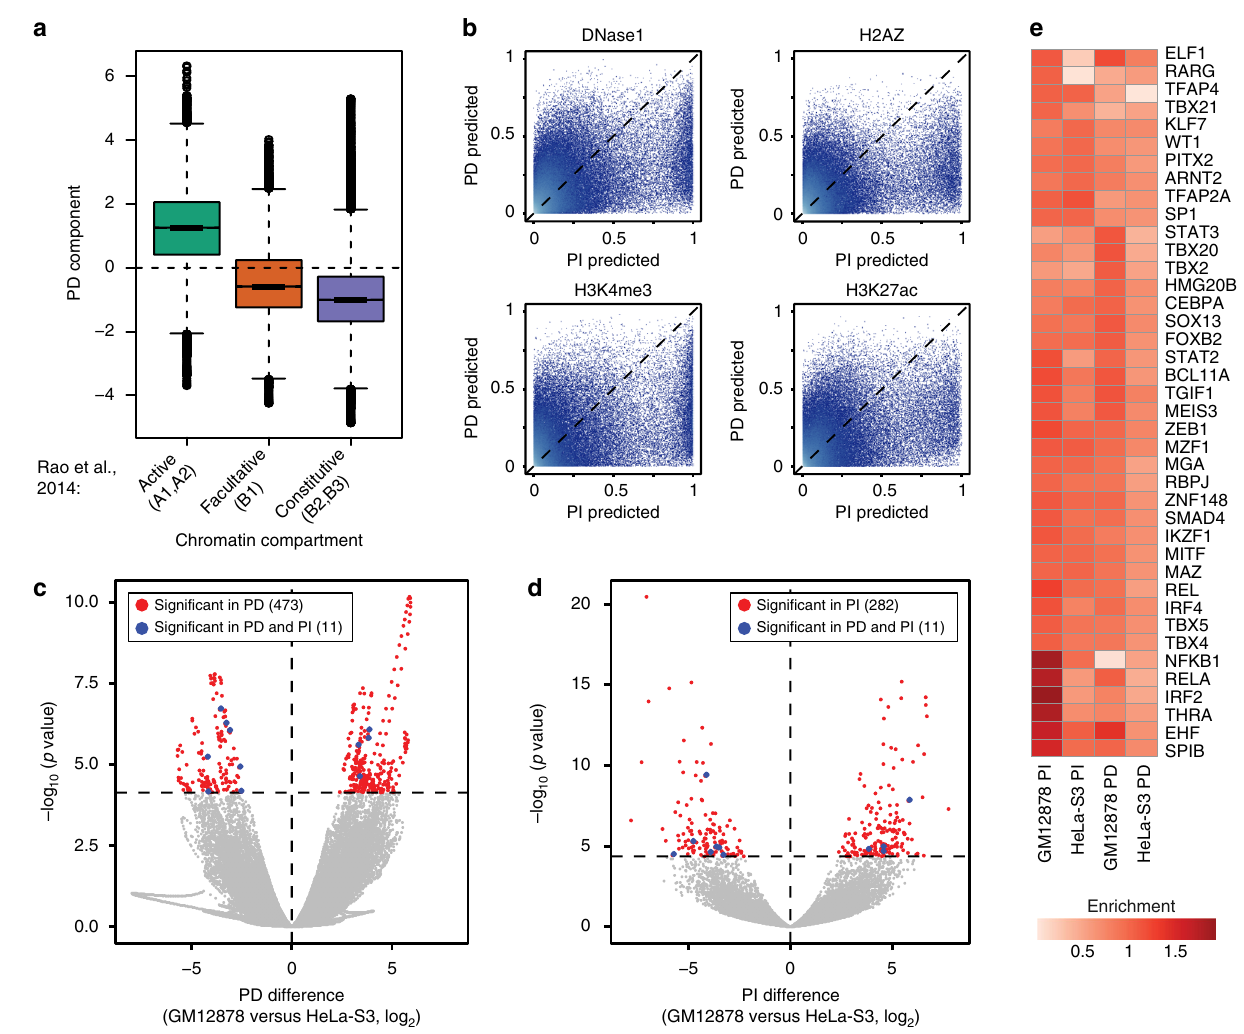
Fig. 3 Transcriptional components reveal chromatin compartments and localised regulatory element-associated effects. a Box-and-whisker plot of GM12878 PD signal grouped according to HiC-derived chromatin compartments. The lower and upper hinges of boxes correspond to the fi rst and third quartiles of data, respectively, and the whiskers extend to the largest and smallest data points no further away than 1.5 times the interquartile range. b Random forest class (presence/absence) probability of DNase1, H2AZ, H3K4me3 and H3K27ac as learned from the PI component ( x axes) and the PD component ( y axes). c PD difference ( x axis, difference in PD value for log-transformed expression) versus false discovery rate (FDR)-adjusted p -value (rescaled by – log 10 ) for PD component differential expression between GM12878 and HeLa-S3. Red represents signi fi cant bins unique to the PD component (corresponding to 473 bins), and blue represents those common to both (11 bins). d As c but for PI component (red: 282 signi fi cant bins unique to the PI component). e Expressed TF motif enrichment around expressed CAGE-derived promoters associated with GM12878 or HeLa-S3-biased differentially expressed PD or PI bins, versus all expressed CAGE-derived promoters. See Supplementary Figure 2e for all enriched expressed Supplementary Fig. 2e), for instance NFKB and IRF in GM12878 cells.